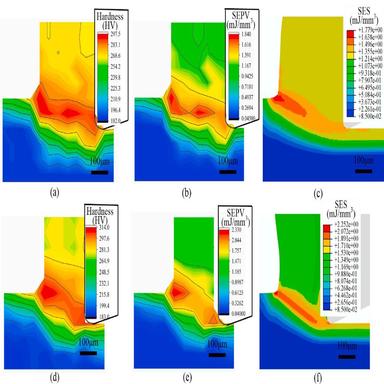
Distributions of the hardness and stored energy in the cutting deformation zones. (a)–(c) present the results at 30 m/min, while (d)–(f) present the results at 150 m/min (a) and (d) present the measurement results of hardness distribution. (b) and (e) present the stored energy distributions obtained from the hardness distributions, while (c) and (f) show the simulation results of SES distribution.